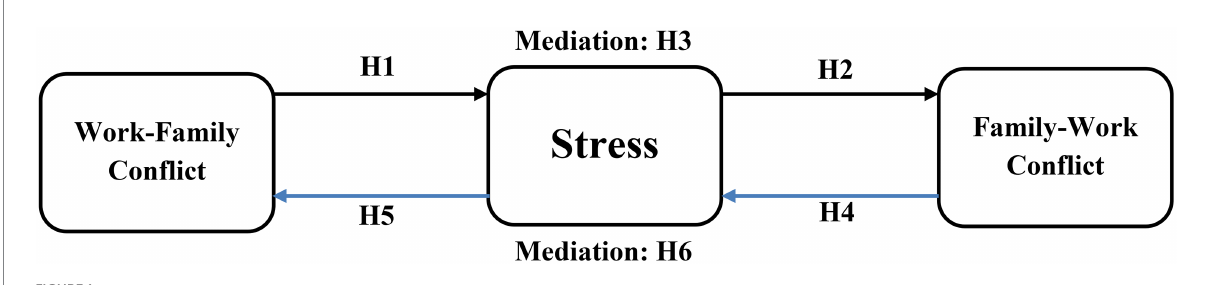
FIGURE 1 Hypothesized research